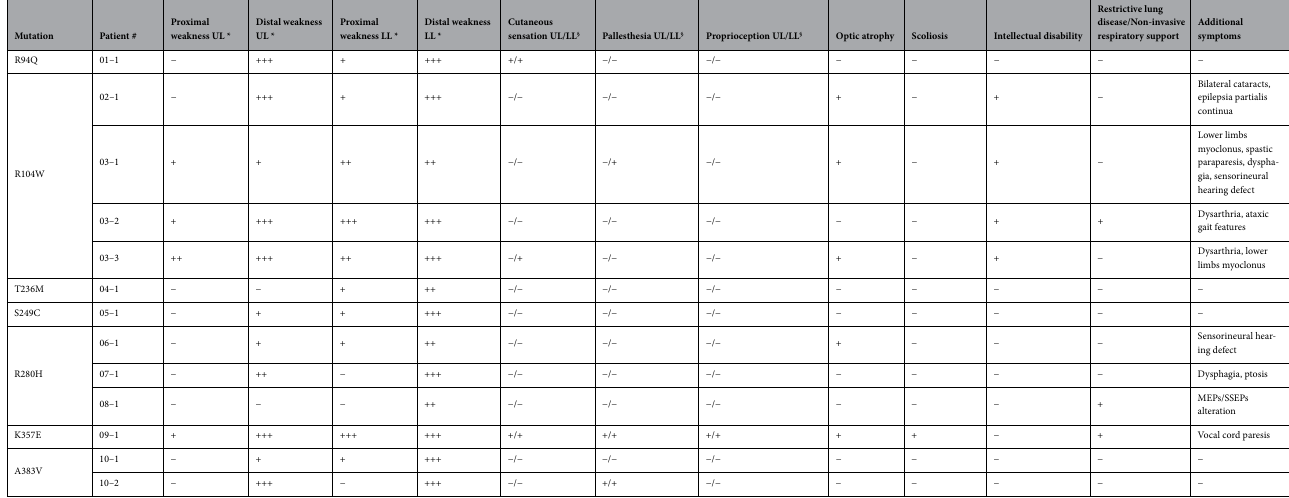
Table 2. Clinical features of patients with MFN2 mutations. LL lower limbs, LMN lower motor neuron, MEP motor evoked potentials, SSEP somato-sensory evoked potentials, UL upper limbs. *Motor weakness assessed by Medical Research Council scale (MRC): UL proximal weakness assessed by deltoids, biceps brachii and triceps, UL distal weakness assessed by first dorsal interosseus, abductor pollicis brevis and adductor digiti minimi muscles, LL proximal weakness assessed by iliopsoas, quadriceps and hamstring muscles, LL distal weakness assessed by anterior tibialis, gastrocnemius and extensor hallucis longus muscles. −: no weakness;